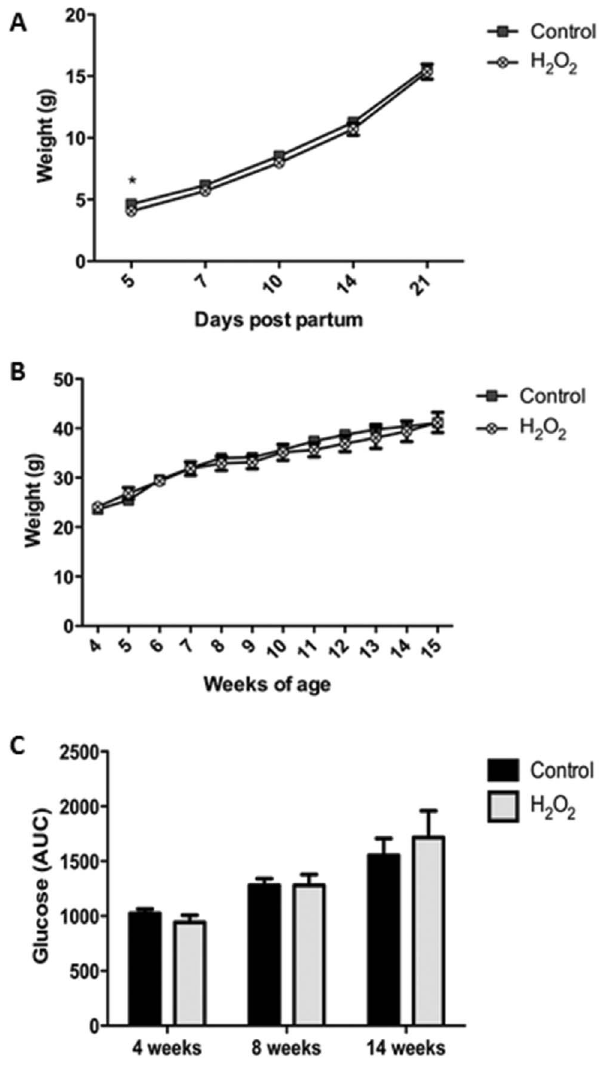
Figure 3. Effect of treatment of sperm with 1500 m M H 2 O 2 on male offspring weight gain and glucose tolerance. (A) pre- weaning weight, (B) post weaning weight, (C) glucose tolerance (AUC). Control male (n=14 mice from 6 litters), H 2 O 2 male (n=7 mice from 5 litters) representative of 15 stud CBAF1 males. Values are mean 6 SEM. * Indicates significantly different from control (P , 0.05).